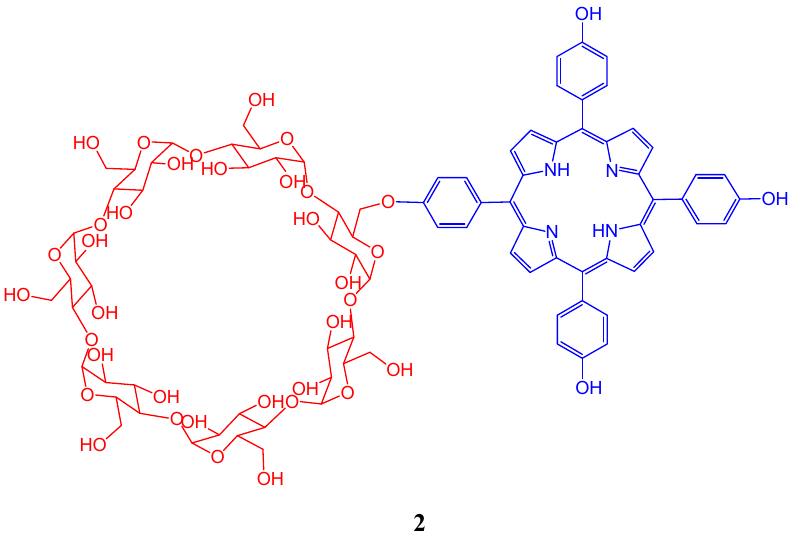
Figure 2. Schematic representation of 5[4-(6- O - β -cyclodextrin)-phenyl],10,15,20-tris(4-